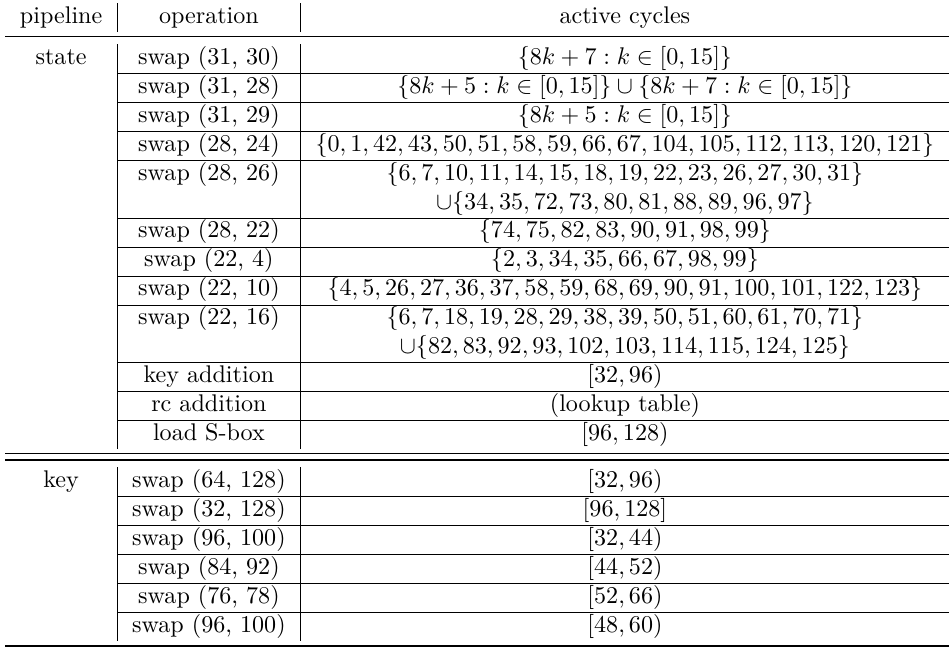
Table 10: The timetable of operations for bit-serial GIFT ∗ encryption. pipeline